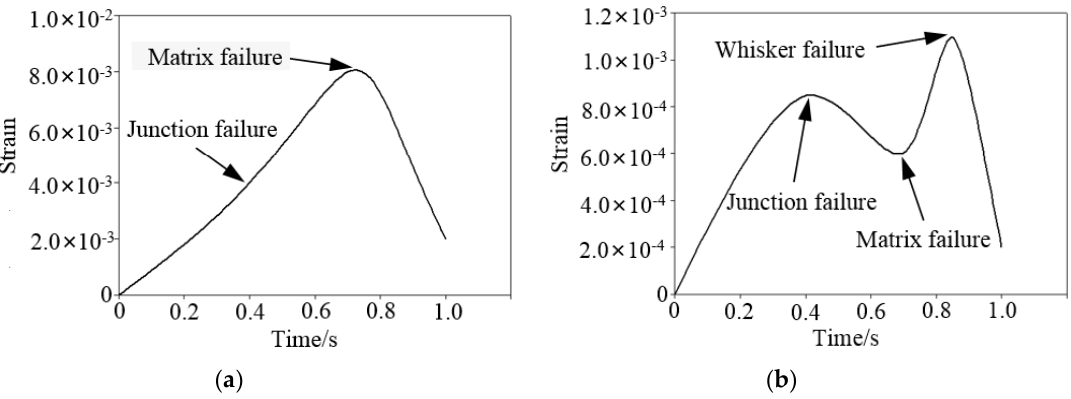
Figure 7. Strain curves of the composite material. ( a ) Strain in the matrix; and ( b ) strain in the whiskers.